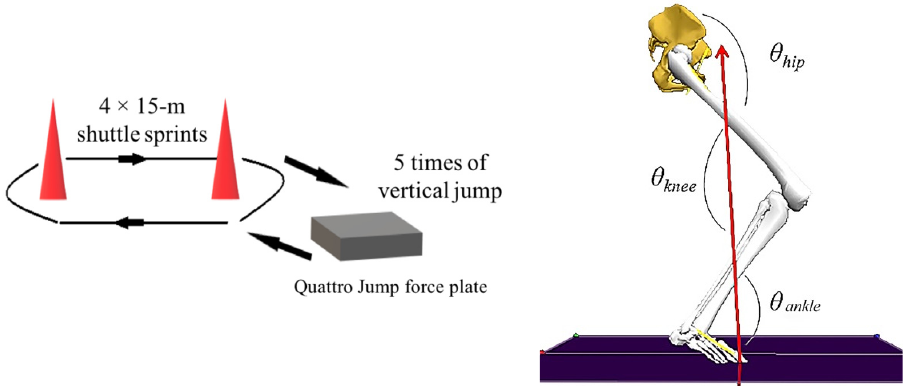
Figure 4. Scheme of fatigue-inducing protocol and joint angle definitions.